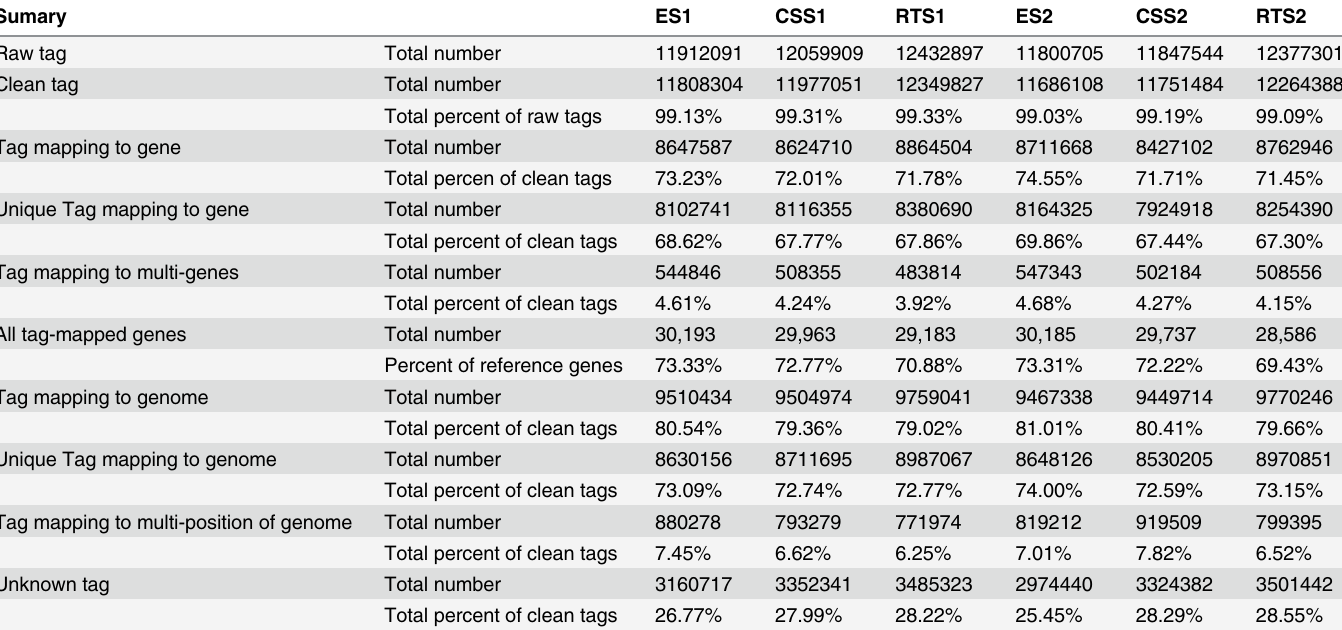
Table 1. Statistics of categorization and abundance of tags generated from the six cDNA libraries for DEGs analysis.